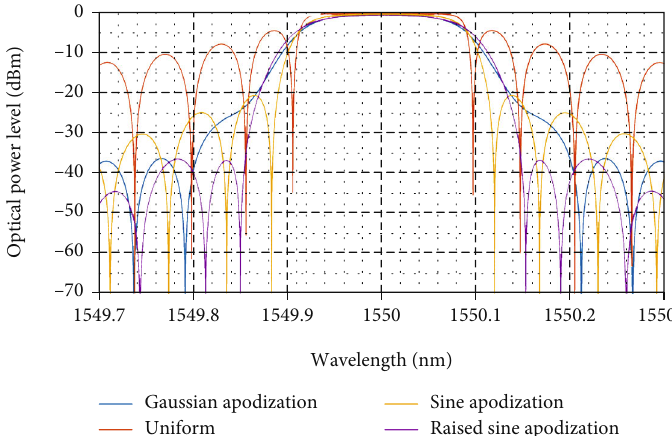
Figure 5: Comparison between the re fl ected signal spectra of FBGs with uniform, Gaussian, sine, and raised sine apodizations ( Δ n = 1 : 5 × 10 − 4 and fi xed grating length